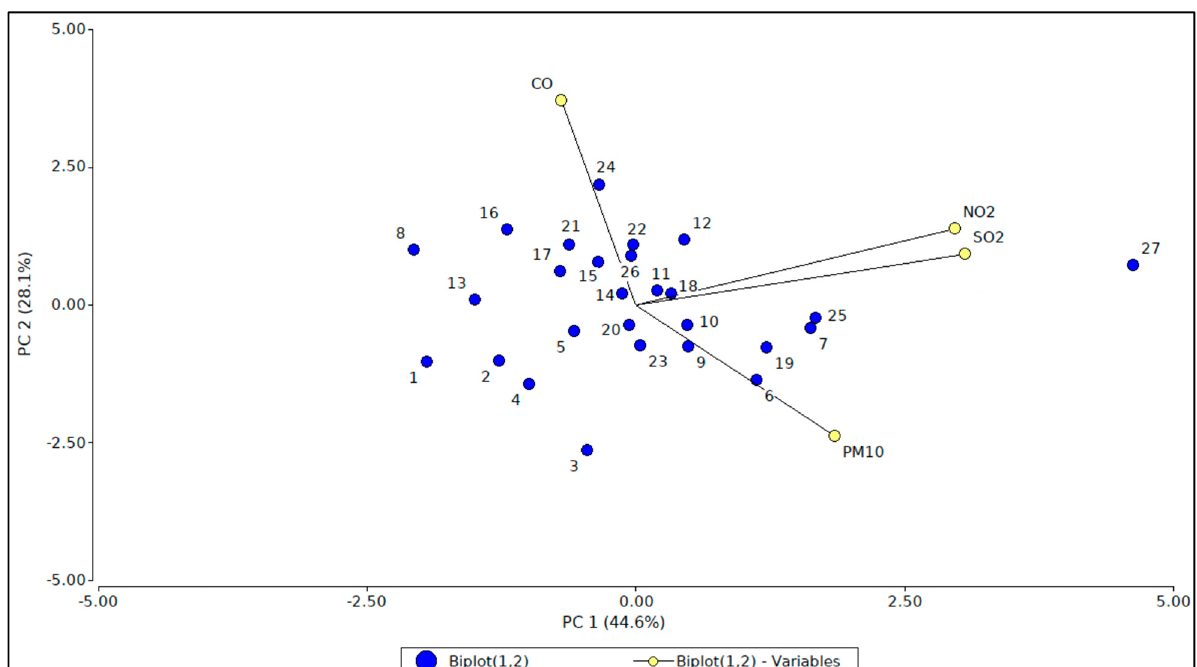
Figure 4. Principal component analysis for the four pollutants studied. For sampling points location, see Figure 1.